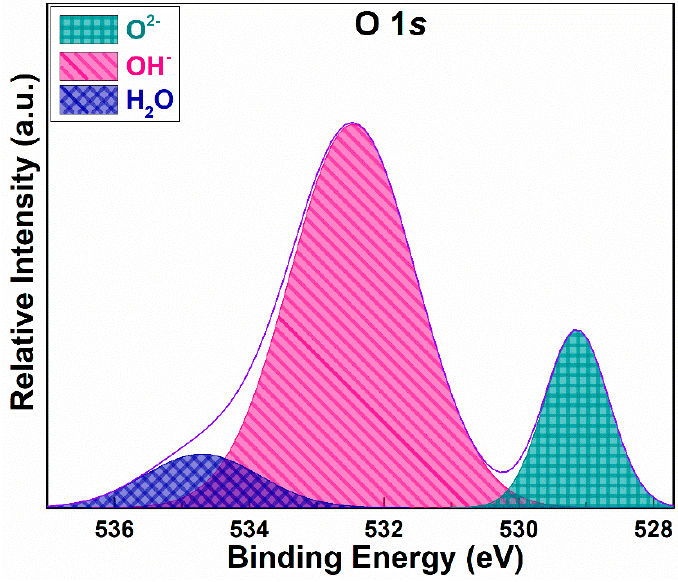
Figure 4. O 1 s spectrum of the catalyst. Table 3. Deconvoluted XPS spectrum of O 1 s distribution in the catalyst. Table 3. Deconvoluted XPS spectrum of O 1 s distribution in the